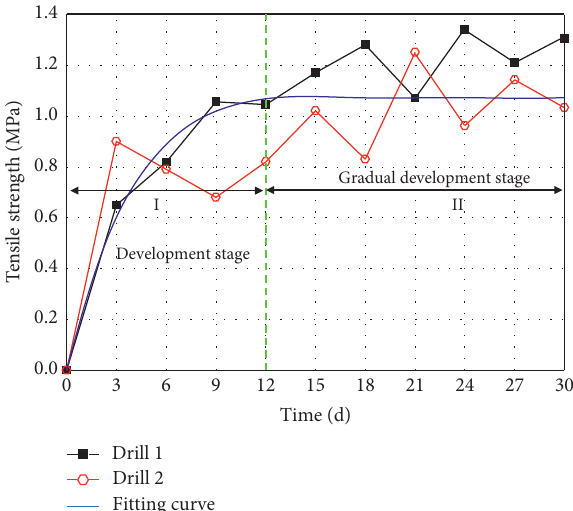
Figure 11: Development of tensile strength with the underground curing